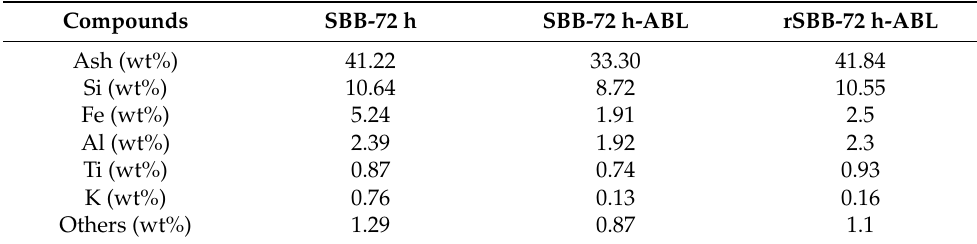
Table 9. Ash and inorganic compounds of treated SCB biochar particles [121].